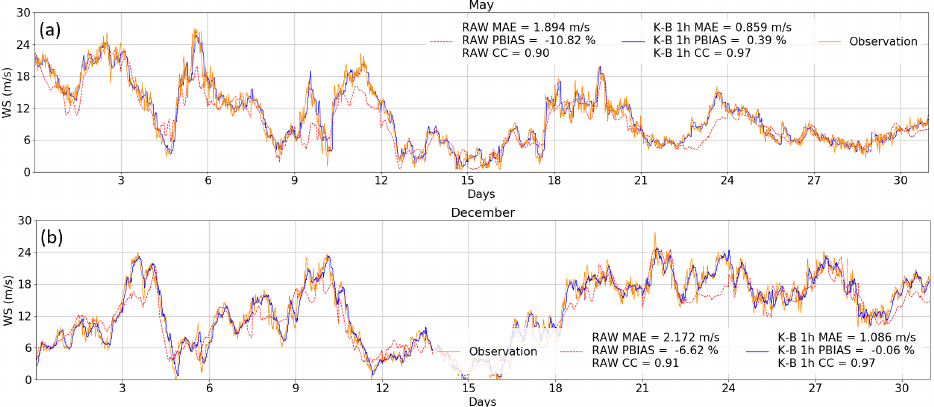
Figure 6. ( a ) Wind speed at hub height in the center area with observations (orange), RAW (dotted red), and K-B 1 h (blue) in May. ( b ) Same as ( a ) in December. Wind speed MAE, PBIAS and Correlation Coefficient (CC) for each series is presented in the legend for both